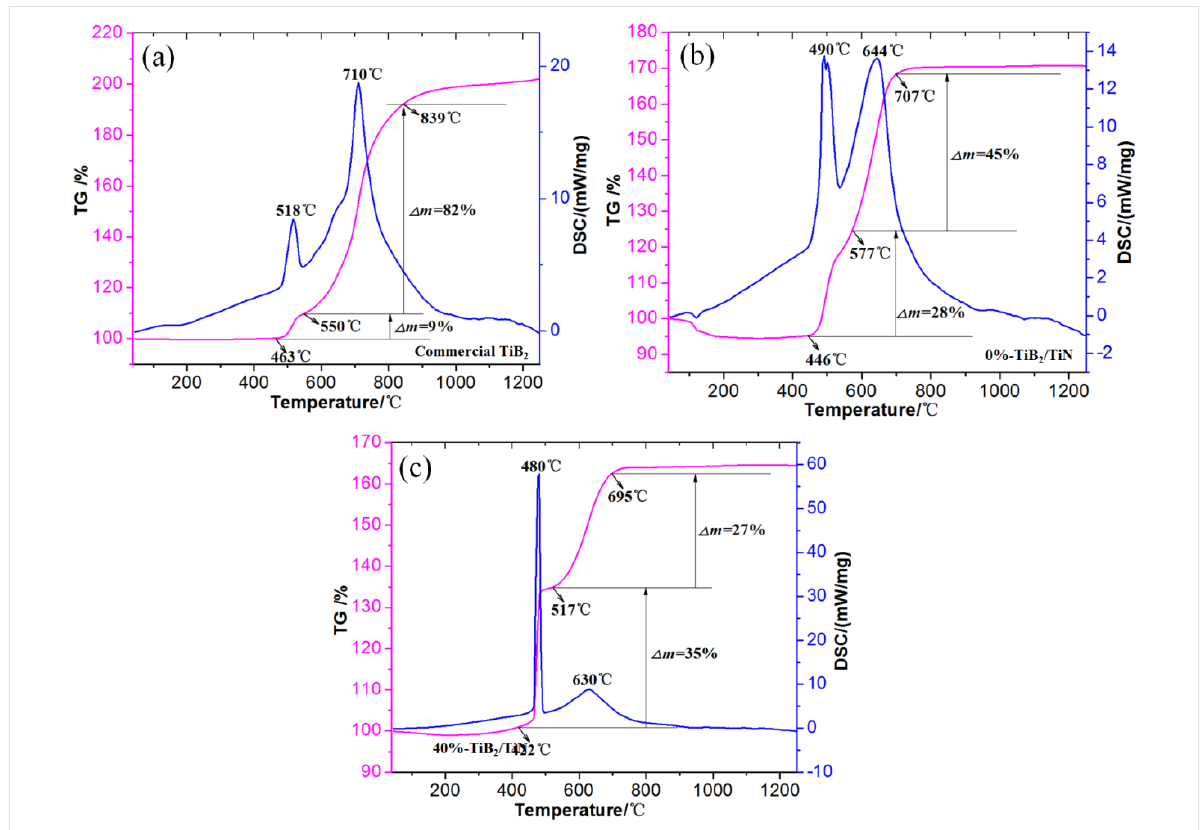
Figure 6: TG-DSC results of three representative samples (a-commercial high purity TiB 2 powders, b-TiB 2 /(TiB 2 –TiN) powders of 0% endothermic rate, c-TiB 2 /(TiB 2 –TiN) powders of 40% endothermic